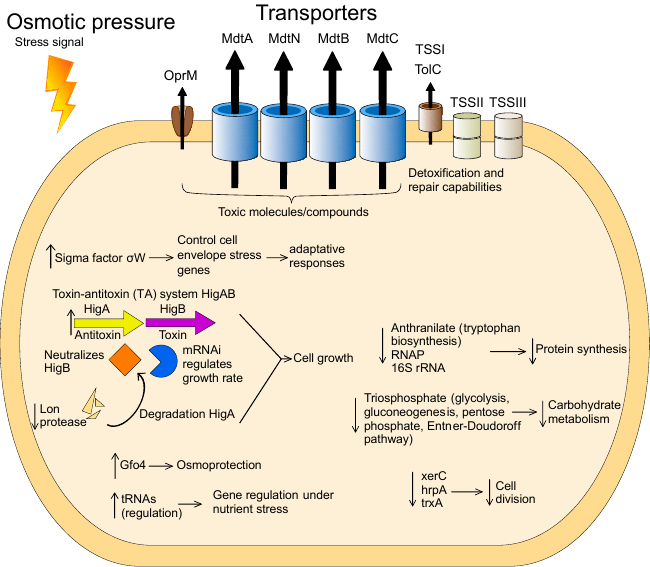
Figure 7. Model of the cellular processes involved in osmotic stress adaptation in Granulicella sp. WH15. The arrows depict upregulation ( ↑ ) and downregulation ( ↓ ) of transcripts and proteins.